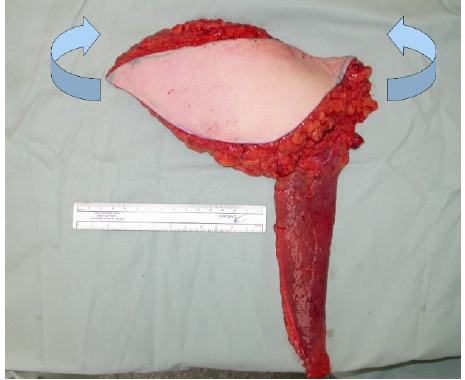
Figure 9. TMG flap before shaping (blue arrows indicate folding of the flap).